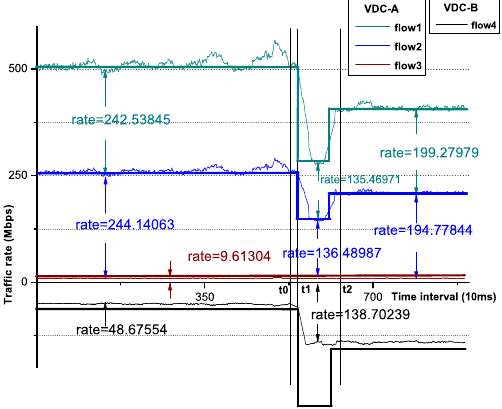
Figure 14. The rapid bandwidth recovery when increasing